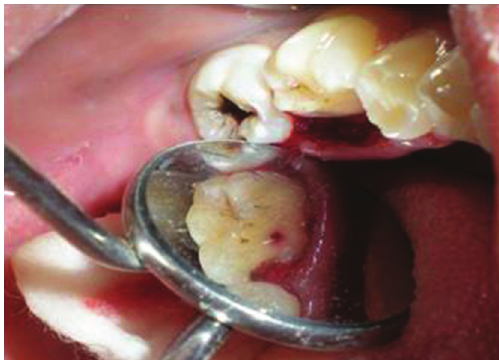
Figure 10: Lingual view of 36, revealing frank pulp exposure after removal of the partially attached dental fragments and surface disinfection with 0.12% chlorhexidine. Surgical site reveals the relationship of fracture to the osseous crest.